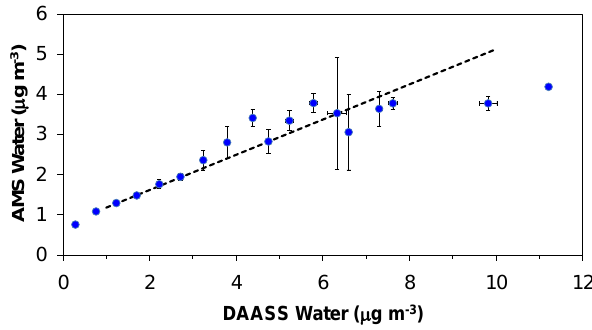
Fig. 6. DAASS water versus AMS water averaged for every 0.5µgm − 3 bin in the DAASS water. Error bars reflect one standard deviation divided by the square root of the total number of samples in that size bin minus one. The DAASS water was measured at am- bient RH while the AMS water at the indoor RH (RH of the sample at room temperature).